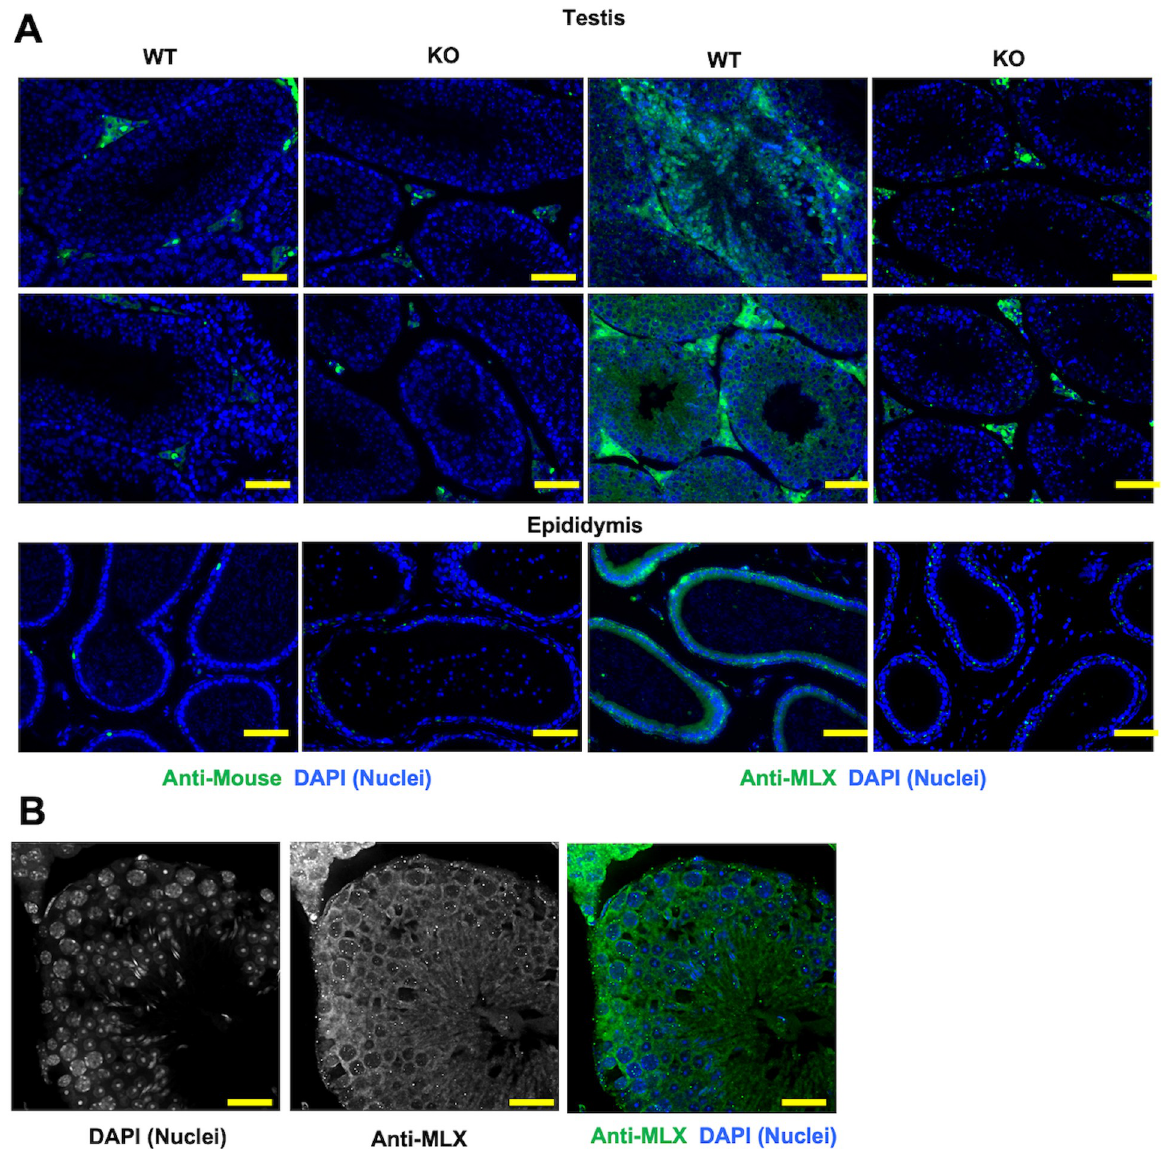
Fig 2. Immunostaining for MLX in WT and MLX KO male reproductive tissue. ( A ) IF analysis of WT versus MLX KO testis and epididymis stained with either secondary alone, or with anti-MLX then secondary antibody (200 × , scale bar = 200 uM). ( B ) IF analysis of WT testis tissue stained with anti-MLX showing the single DAPI and MLX, as well as combined, channels (400 × , scale bar = 100 uM). IF, immunofluorescence; KO, knockout; MLX, MAX-Like protein X; WT, wild-type.